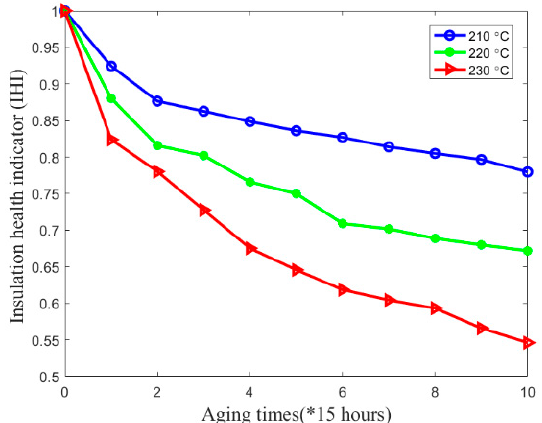
Figure 22. Relationship between insulation health indicator ( IHI ) and resonant frequency under ( a ) 210 °C, ( b ) 220 °C, and ( c ) 230 °C.